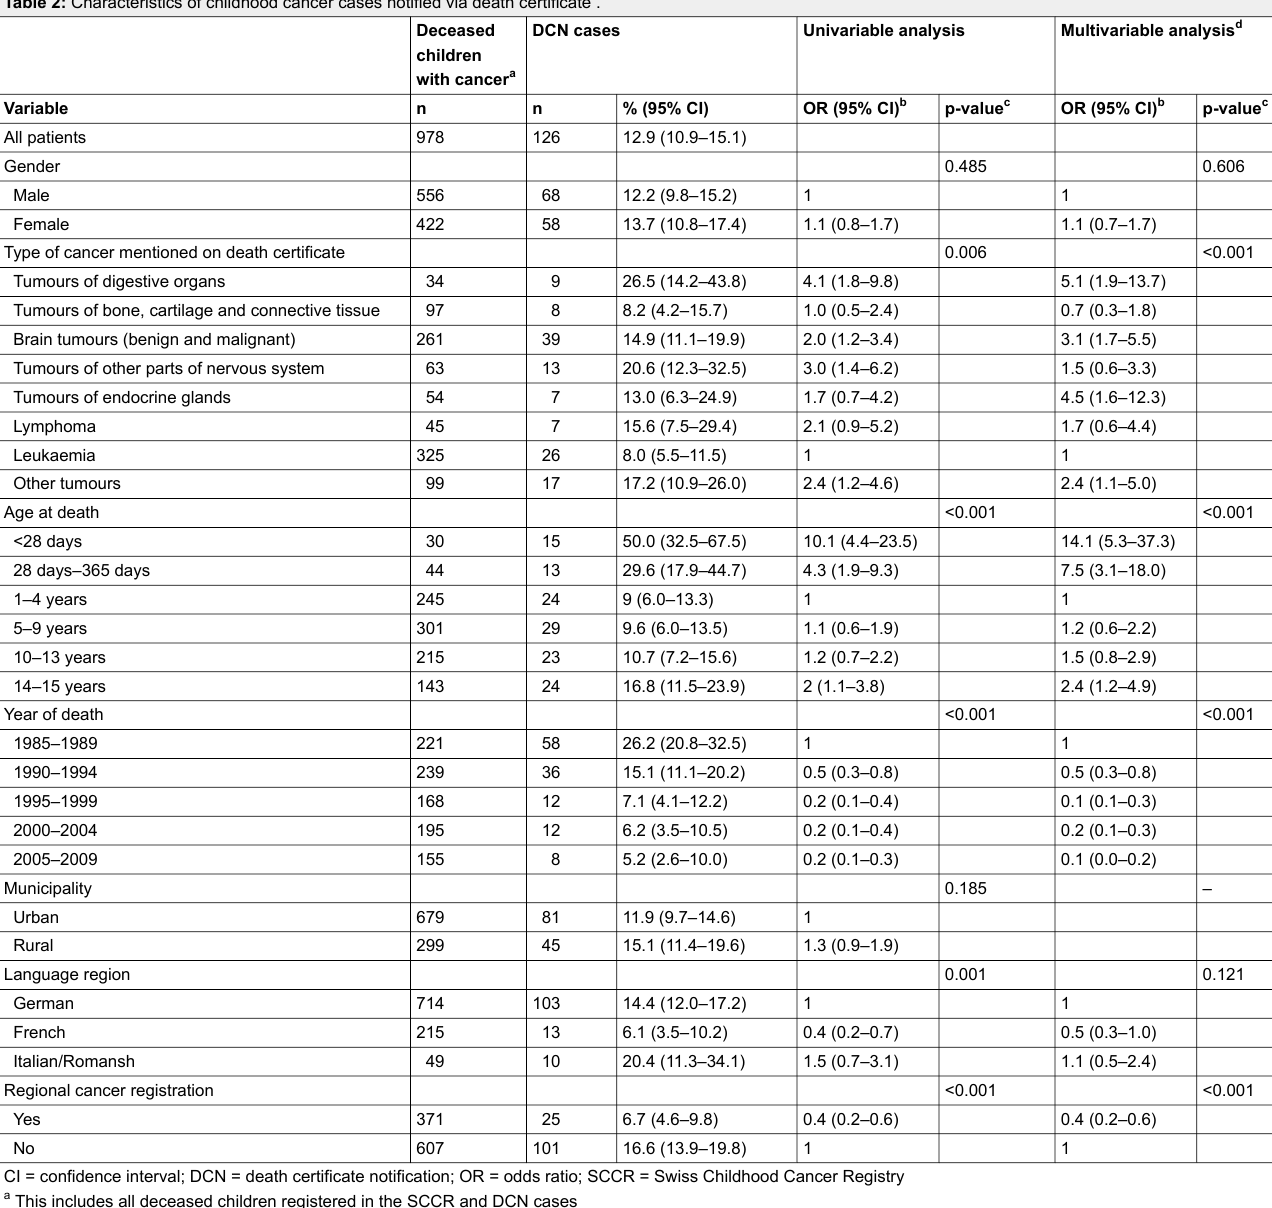
Table 2: Characteristics of childhood cancer cases notified via death certificate